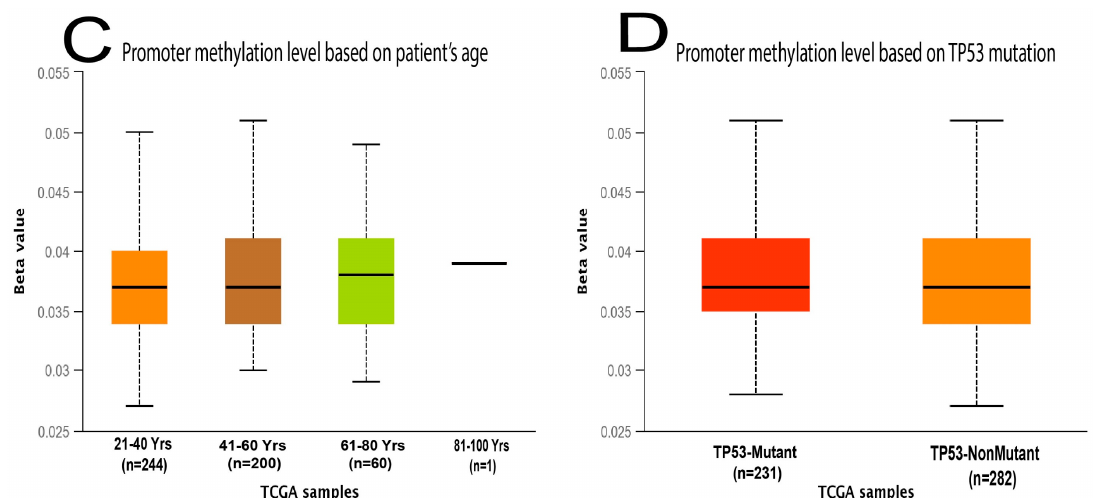
Figure 4. The UALCAN database was used to determine the promoter methylation status of the MDM2 gene for LGG cancer depending on multiple variables. ( A ) The extent to which MDM2’s promoter is methylated in LGG is determined by the patient’s race. ( B ) The extent to which MDM2’s promoter is methylated in LGG is determined by the patient’s gender. ( C ) MDM2 promoter methylation levels in LGG are determined by the patient’s age. ( D ) MDM2 promoter methylation level in LGG as a function of TP53 mutant status. The beta value, according to UALCAN, shows the degree of DNA methylation, ranging from 0 (that means completely unmethylated) to 1 (that means completely methylated). The bold p -value shows the statistical significance.